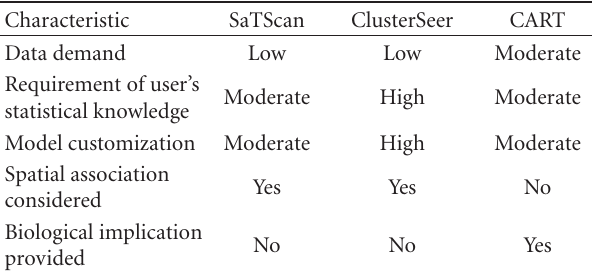
Table 3: Comparisons of SaTScan, ClusterSeer, and CART methods in hotspot